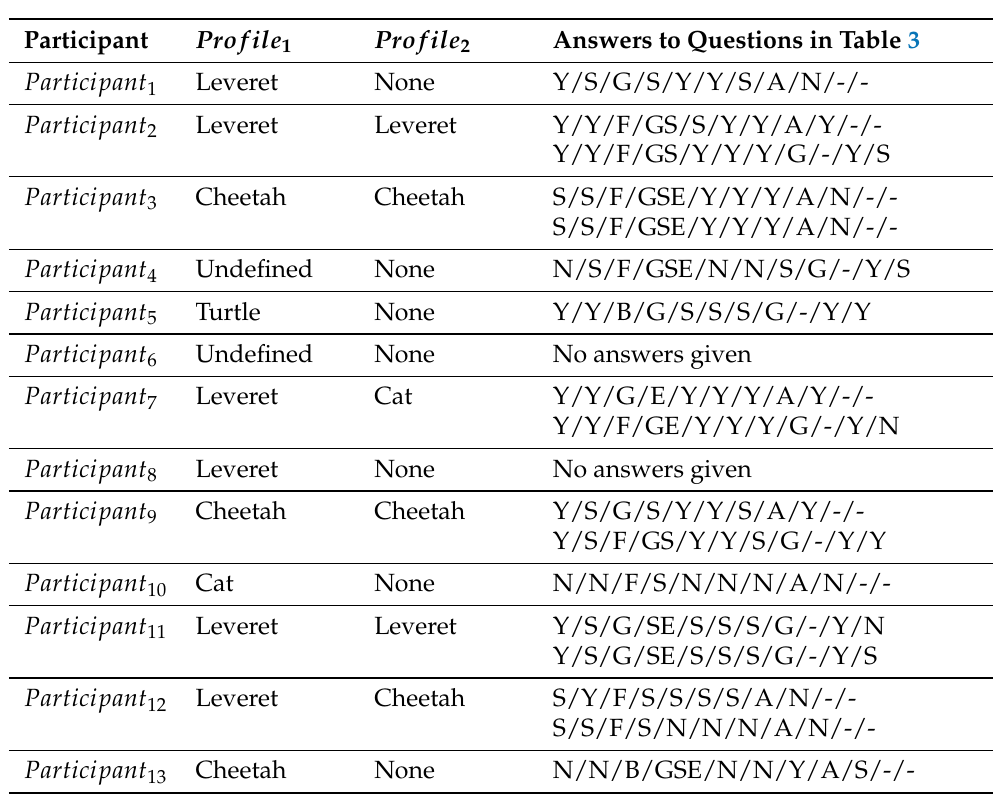
Table 4. Results of data